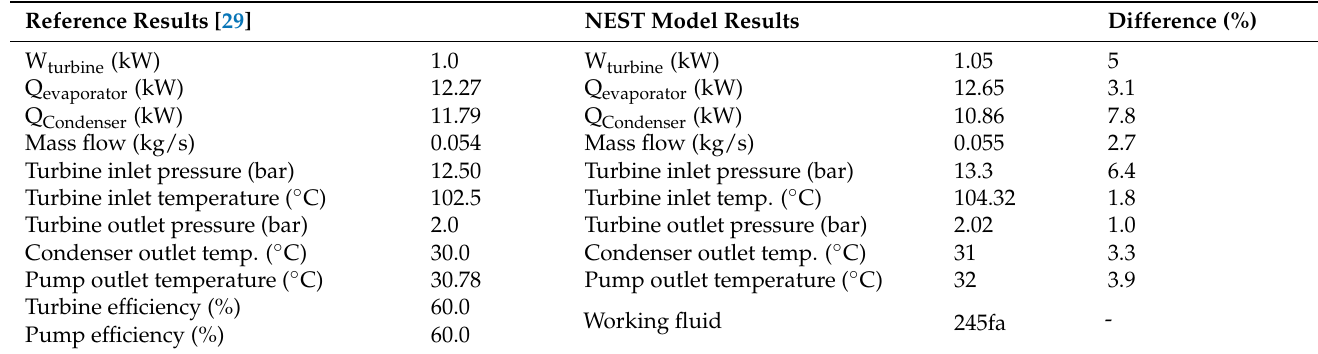
Table 3. Validation of the mathematical model of the Organic Rankine Cycle.